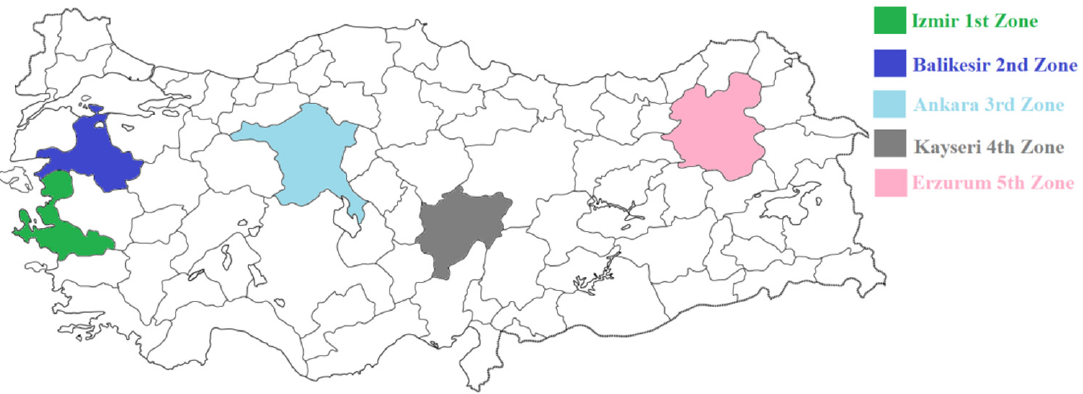
Figure 2. Selected cities according to five different climate zones in Turkey [31].